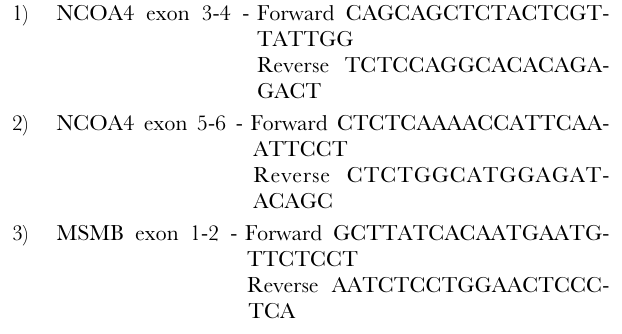
Figure S2 Expression of TIMM23 at chromosome 10q11 is not associated with genotype at rs10993994 in prostate tissue. A. Expression in histologically normal prostate tissue (n= 84, p = 0.3459). B. Expression in prostate tumor tissue in the Dana-